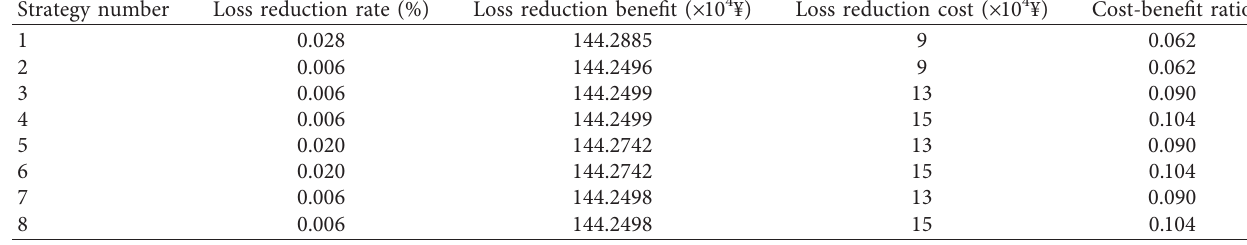
Table 6: Cost-benefit calculation results of individual loss reduction strategies (distribution transformers).